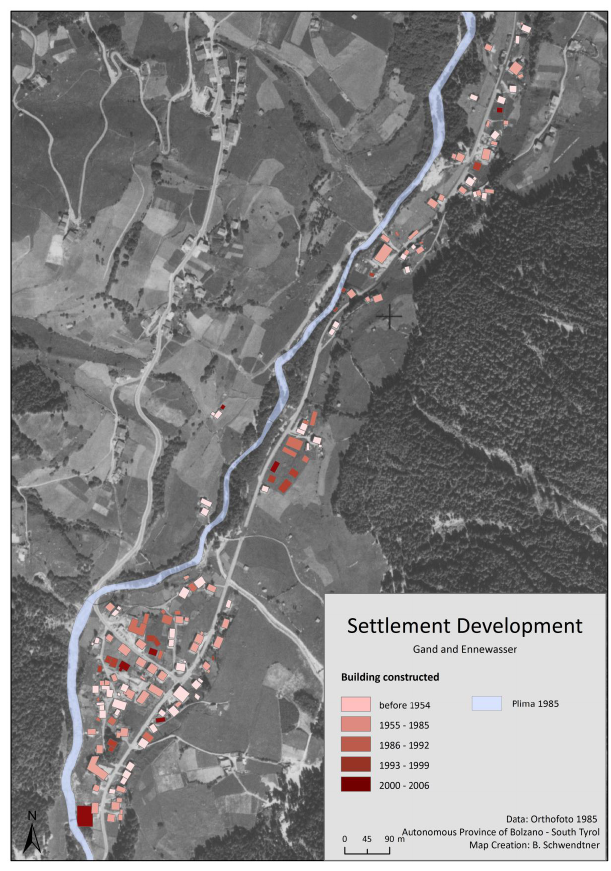
Fig. 6. Settlement development in Gand and Ennewasser from be- Figure 6. Settlement development in Gand and Ennewasser from before 1954 until 2006. 2 fore 1954 until